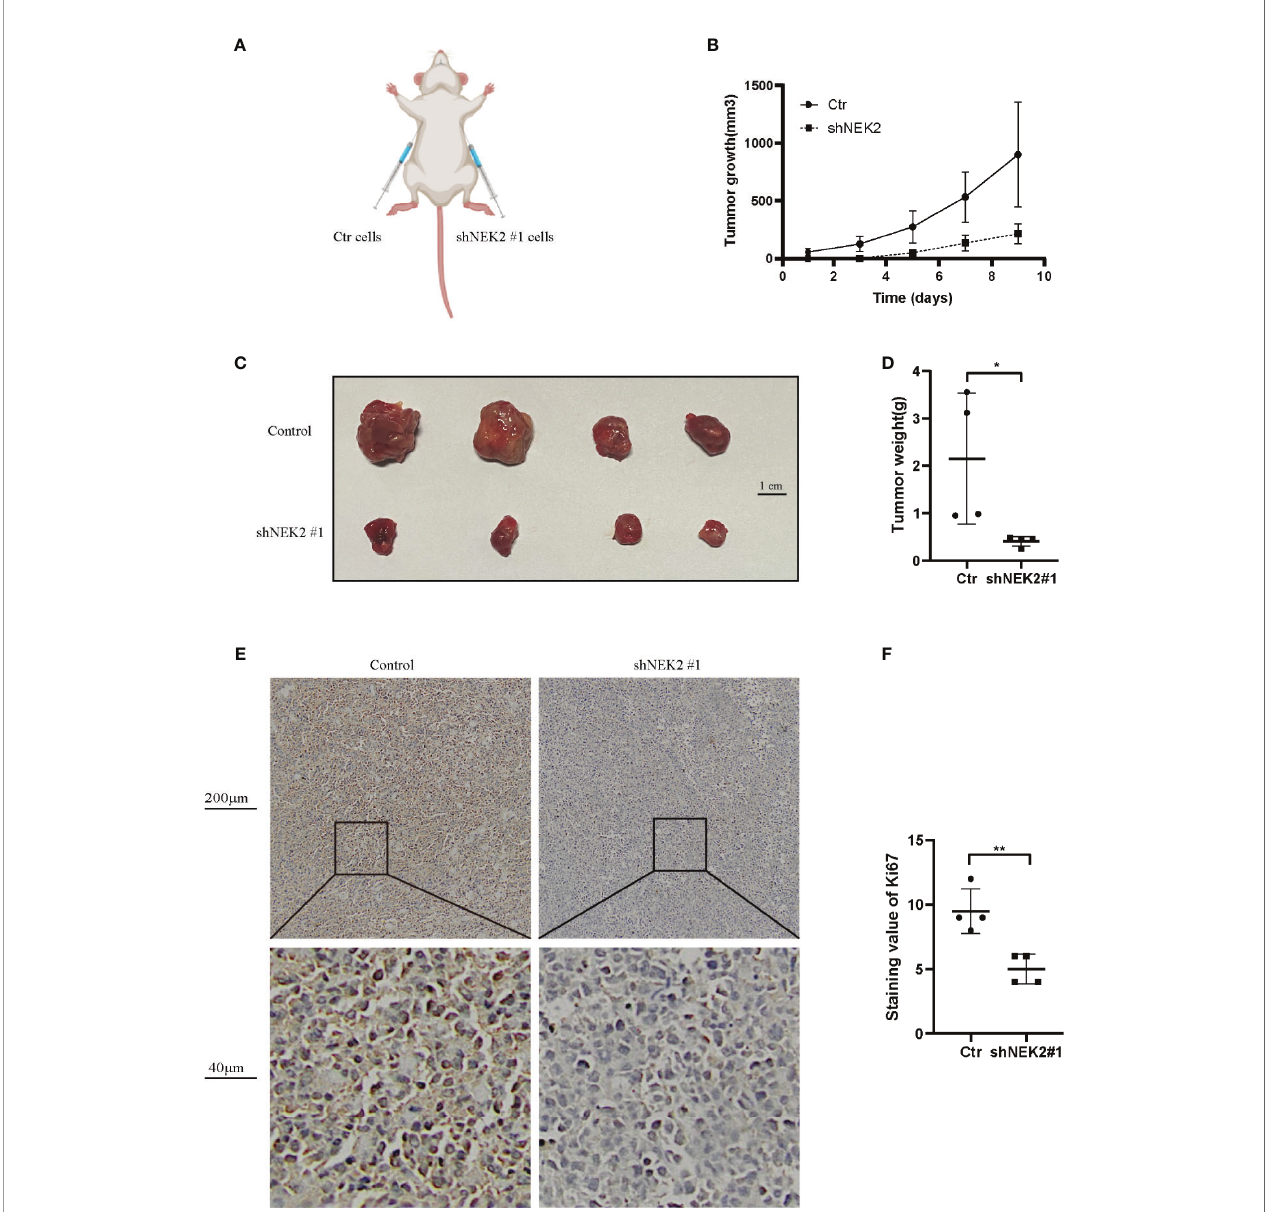
FIGURE 7 | NEK2 promotes tumorigenicity in vivo . (A) Scheme of xenograft studies with shNEK2- or non-target control shRNA-expressing cells; (B) Growth curves of xenografted tumors which were monitored every 2 day; (C) Photograph of xenograft tumors. (D) Bar chart represents tumor weight of xenografted tumors, knockdown of NEK2 signi fi cantly decreased the growth of DLBCL cells in NOD/SCID mice (*P < 0.05, Student ’ s t-test); (E, F) The tumor sections were subjected to IHC staining with ki-67, the IHC score of Ki67 of the control group was signi fi cantly higher than knockdown of NEK2 group (**P < 0.01, Student ’ s